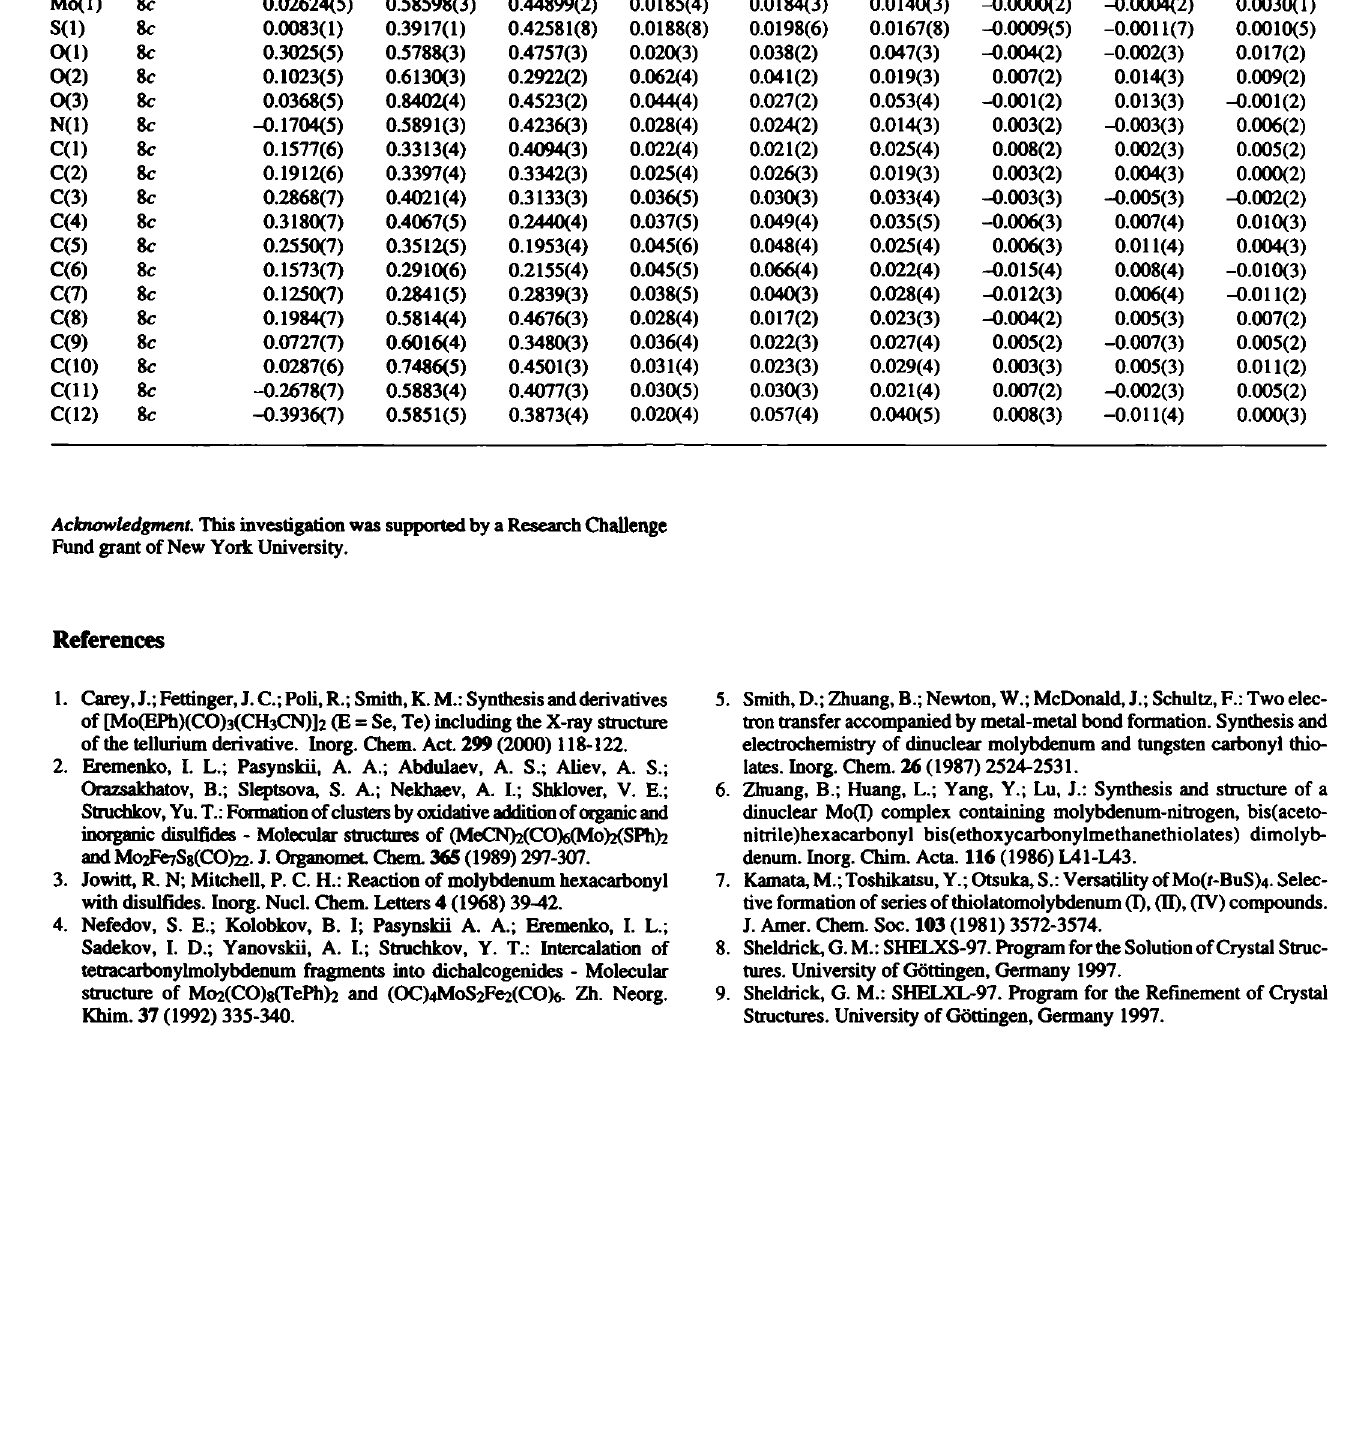
Table 3. Atomic coordinates and displacement parameters (in Â 2